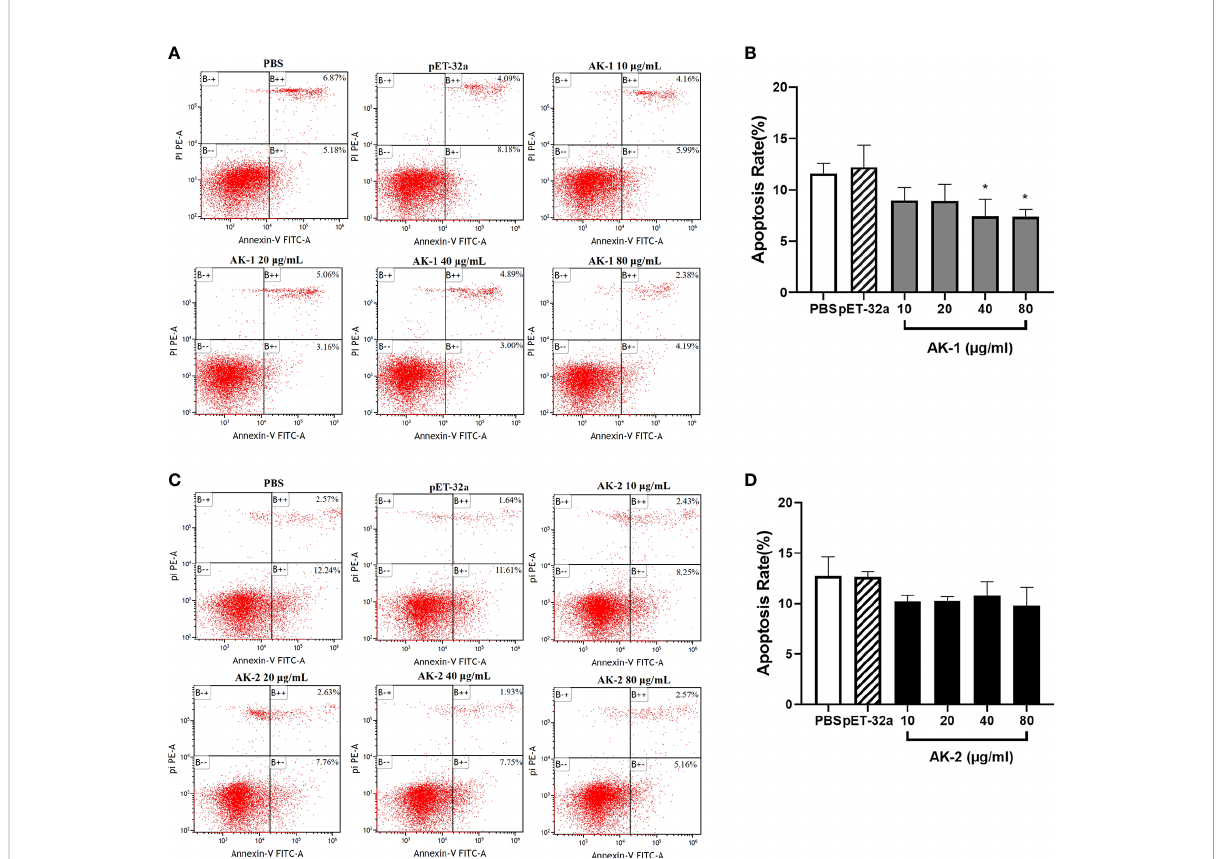
FIGURE 7 The effects of the rSsAKs on PBMC apoptosis. Annexin V/PI staining and fl ow cytometry detection of the effects of the rSsAKs on PBMC apoptosis. (A, C) Annexin V/PI staining and fl ow cytometry were used to detect the effects of rSsAK-1 (A) and rSsAK-2 (C) on PBMC apoptosis. (B, D) Changes in the total apoptosis rate of PBMCs stimulated by rSsAK-1 (B) and rSsAK-2 (D) . The total apoptosis rate was the sum of the early and late apoptosis rates. Data are the mean ± SD of three replicates per group as compared to the PBS group. * P <